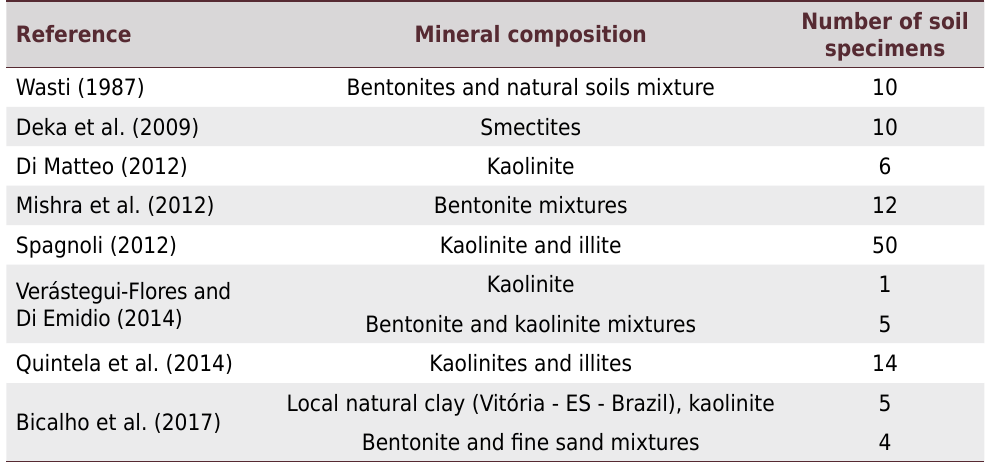
Table 1. Summary of publications, mineral composition, and number of Specimens (n) of the soils investigated in group B-01 (LL p and LL c-hard base ) with a total of 117 tested soil specimens